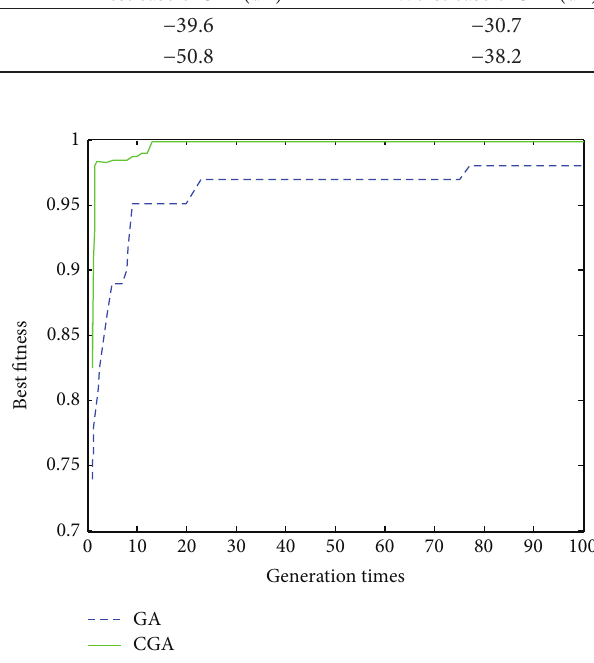
Figure 5: The normalized pattern used improved chaotic genetic algorithm and the traditional genetic algorithm.